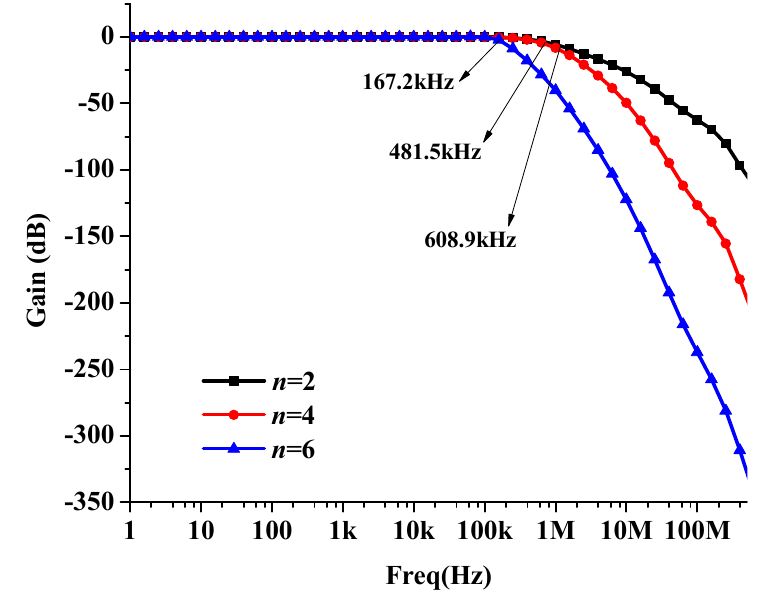
Figure 4. Simulated amplitude-frequency responses of the LPF with different orders.